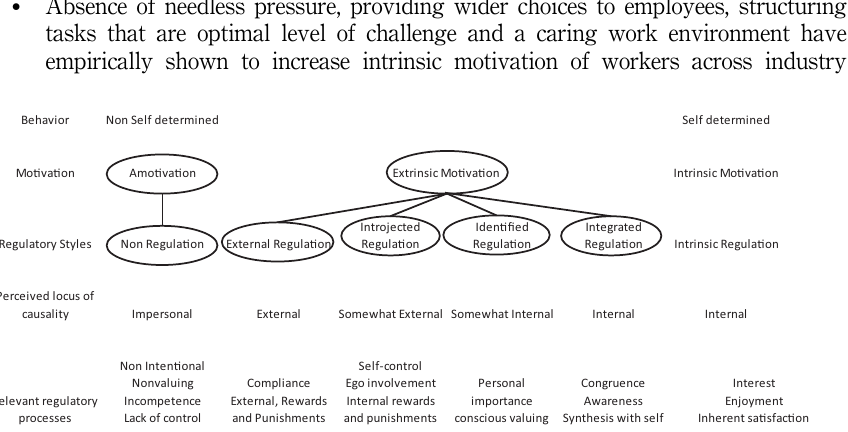
Figure 1. Self-determination continuumshowing types ofmotivation with theirregulatory styles,lociofcausality andcorresponding